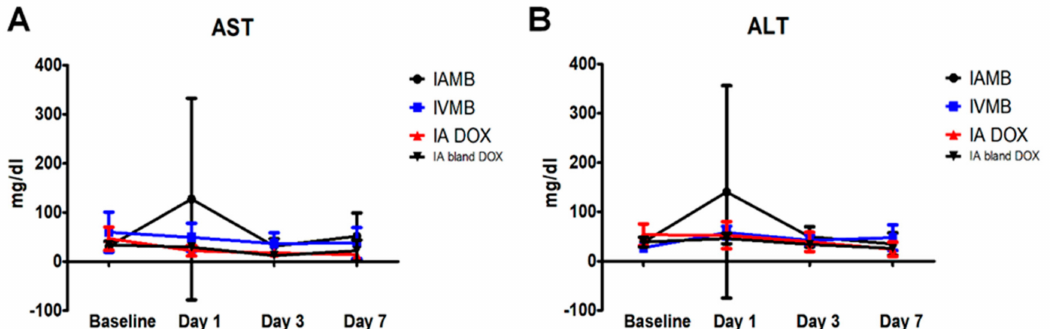
Figure 9. Graphs depicting liver enzyme values (AST and ALT) changes over the observation period for each treatment group. ( A ) Graph depicting the plasma concentration changes in aspartate transaminase (AST) over the 7-day observation period (expressed in mg / dl). ( B ) Graph depicting the plasma concentration changes in alanine transaminase (ALT) over the 7-day observation period. No significant changes in AST and ALT levels at each time interval throughout the observation period among the five